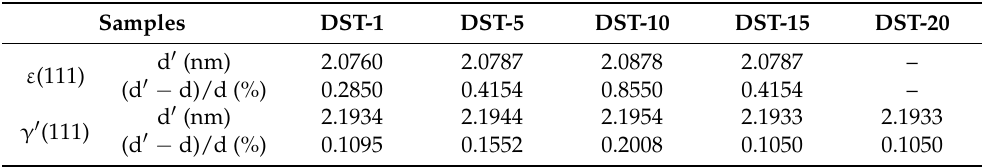
Table 1. Lattice spacing was calculated from ε (111) and γ ′ (111) planes in the surface layer of the DST samples, excluding the Ni element layer.